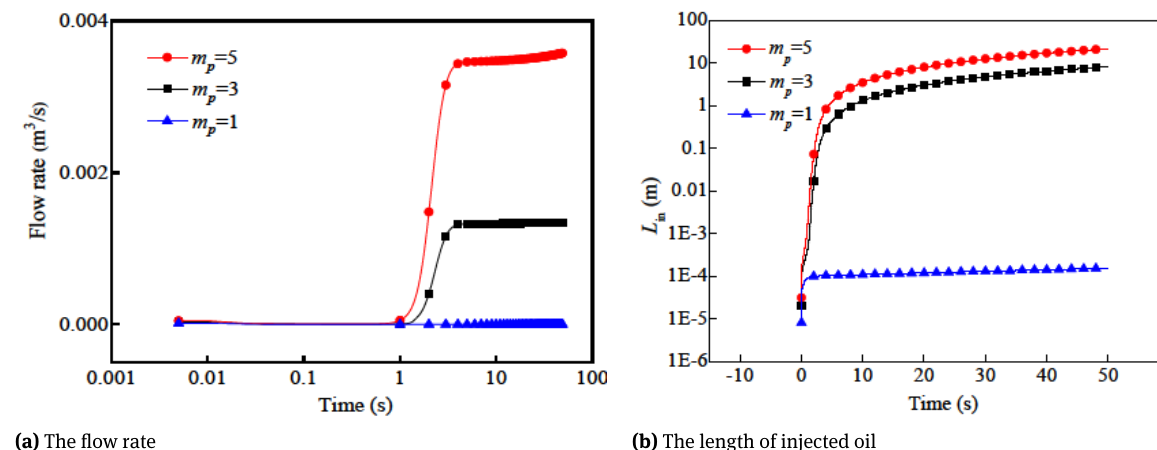
Figure 12: The flow rate and length of injected oil of Model 1